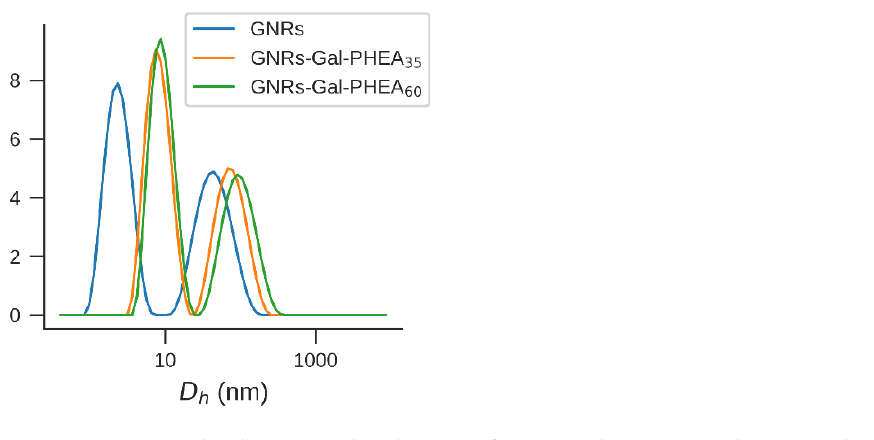
Figure 5. Intensity-weighted DLS size distributions of GNRs-Gal-PHEA35 and GNRs-Gal-PHEA60 compared to bare GNRs.